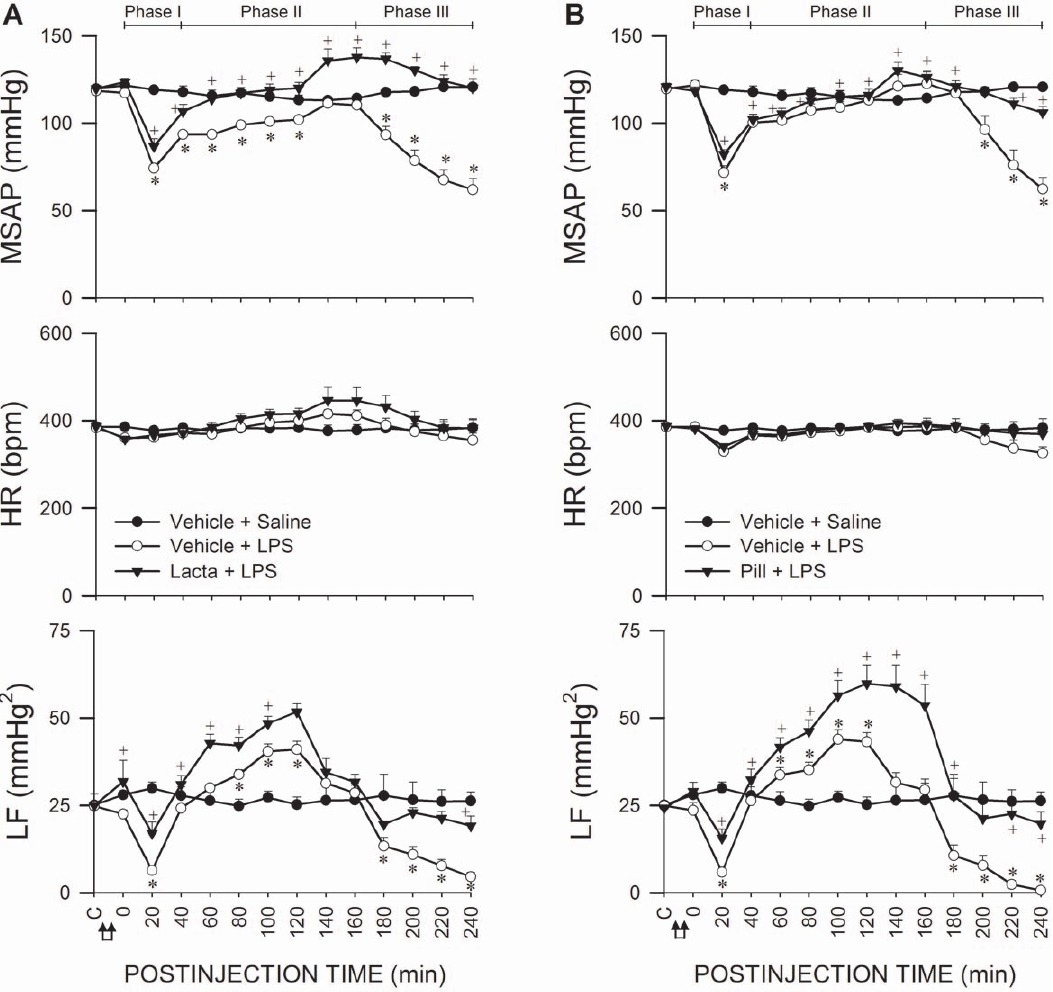
Figure 1. UPS in RVLM participates in brain stem cardiovascular regulation during experimental brain death. Temporal changes in mean systemic arterial pressure (MSAP), heart rate (HR) or power density of the low-frequency (LF) component of SAP signals in rats that received pretreatment by microinjection bilaterally into RVLM of lactacystin (Lacta; 1 nmol) (A), proteasome inhibitor II (PiII; 1 nmol) (B) or their solvents (Vehicle), followed by IV administration (at arrows) of LPS (15 mg kg 2 1 ) or saline. Values are mean 6 SEM; n=7–8 animals per group. * P , 0.05 versus Vehicle + Saline group, and + P , 0.05 versus Vehicle + LPS group at corresponding time-points in the Scheffe´ multiple-range test. C, baseline. Demarcation of Phases I, II and III according to the decrease, increase and secondary decrease of LF power is shown on top of the diagrams.